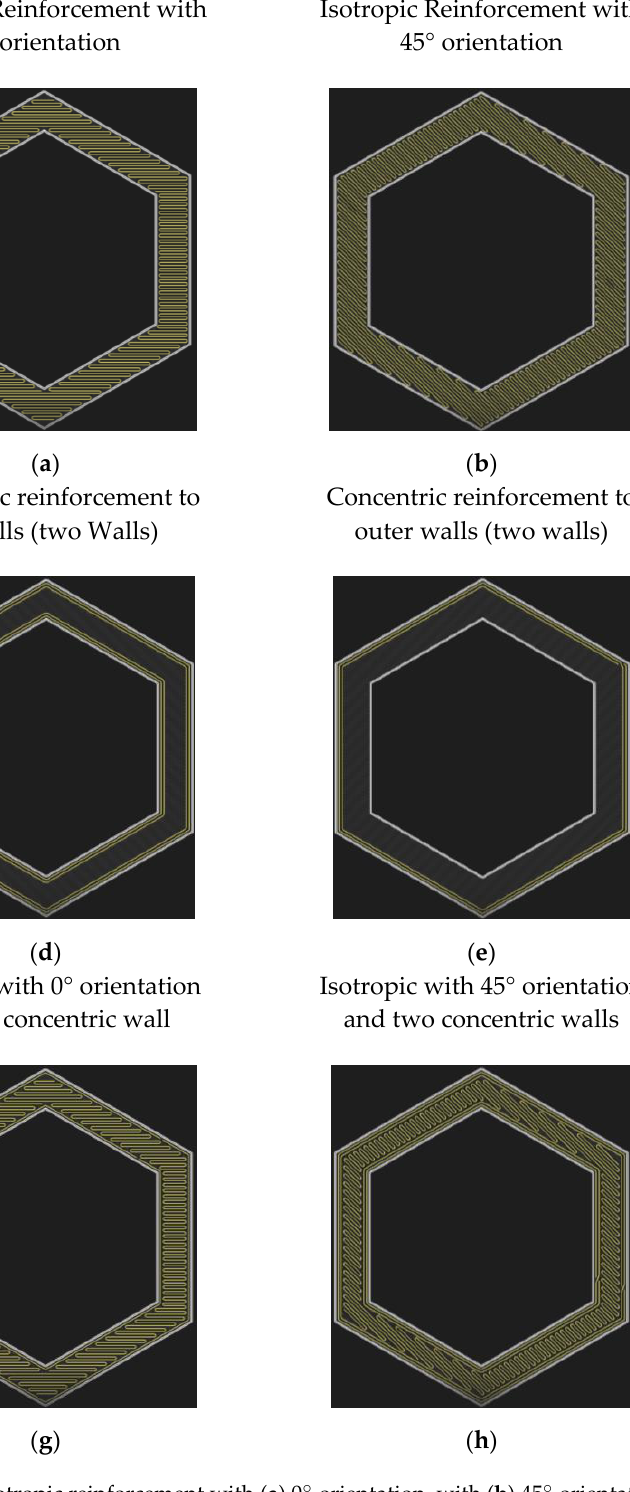
Figure 1. Isotropic reinforcement with ( a ) 0° orientation, with ( b ) 45° orientation and ( c ) 90° orientation, ( d ) concentric fiber reinforcement for all walls, ( e ) for outer walls and ( f ) for inner walls. ( g ) Isotropic fill reinforcement with 0°, ( h ) 45° and ( i ) 90° with one, two and three concentric walls, respectively.